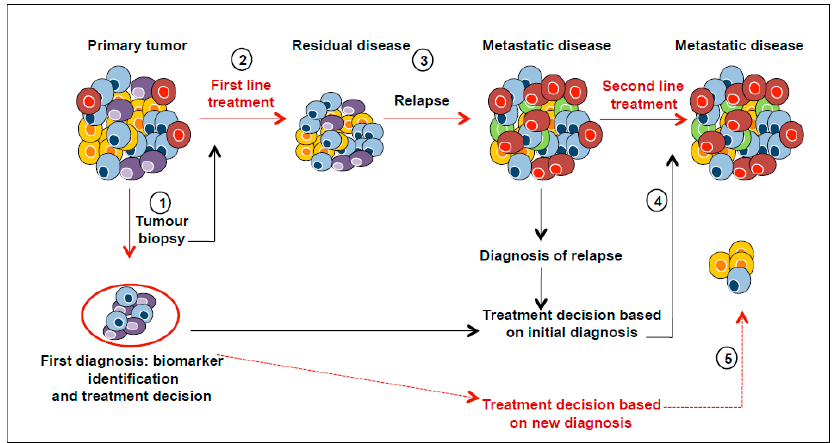
Figure 4. Effects of tumour heterogeneity on the predictive value of biomarkers. Cancer diagnosis is commonly based on a biopsy ( 1 ) that contains only a small fraction of tumour and may thus not be representative of all the subclones (cells in different colours). The first line treatment can be successful in eliminating dominant clones ( 2 ), but resistant clones are selected and drive disease progression ( 3 ). Metastases can develop from primary tumour cells, or from clones that survive the initial therapy. Therefore, the clonal composition of metastatic lesions may be completely different from that of the primary tumour sample, and treatments based on the initial diagnostic sample may be suboptimal for the treatment of metastatic disease ( 4 ). New diagnosis after a relapse must be made before applying a second line treatment (dashed-red lines) ( 5 ). (Adapted from Almendro et al.) [68].